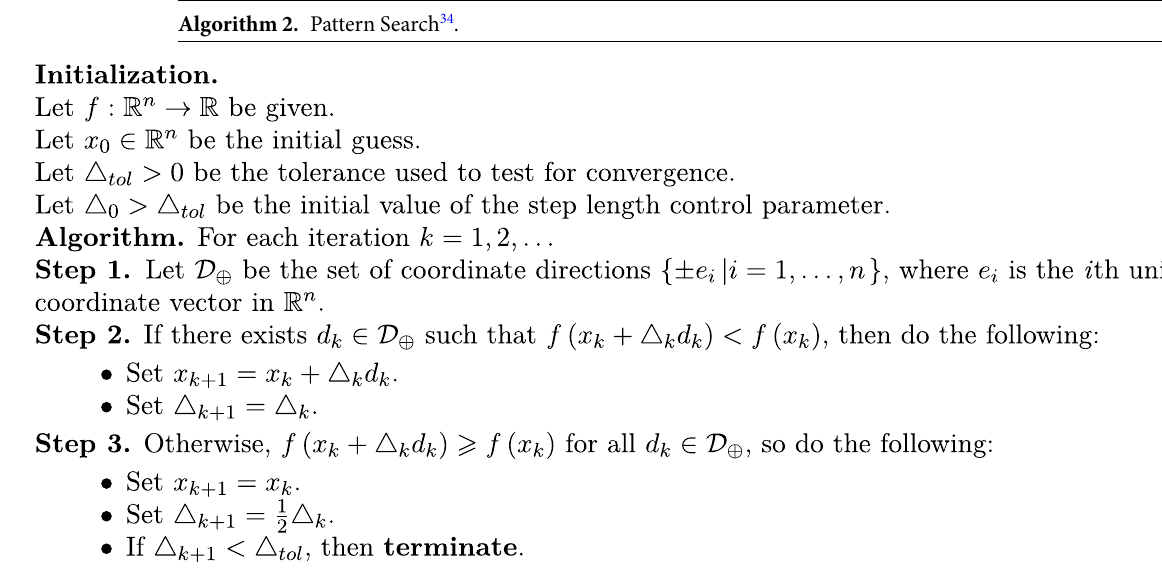
Figure 3. Up-Left: A dog aortic pressure cycle (in blue), its dicrotic notch (black circle with dotted center), and the IMF (in red). Up-Right: heat-map plot of ω solution marked with red dot. Down-Left: Contour plot of ω is shown by a red dot. Down-Right: Contour plot of ω tracked by the pattern search. The beginning of the pattern search is marked with a triangle and its end with a circle. The true optimum point is marked with a red dot. The lower pattern search set (in black) has converged towards the correct optimum. The upper pattern search set (in magenta) has converged to a local minima near the node.